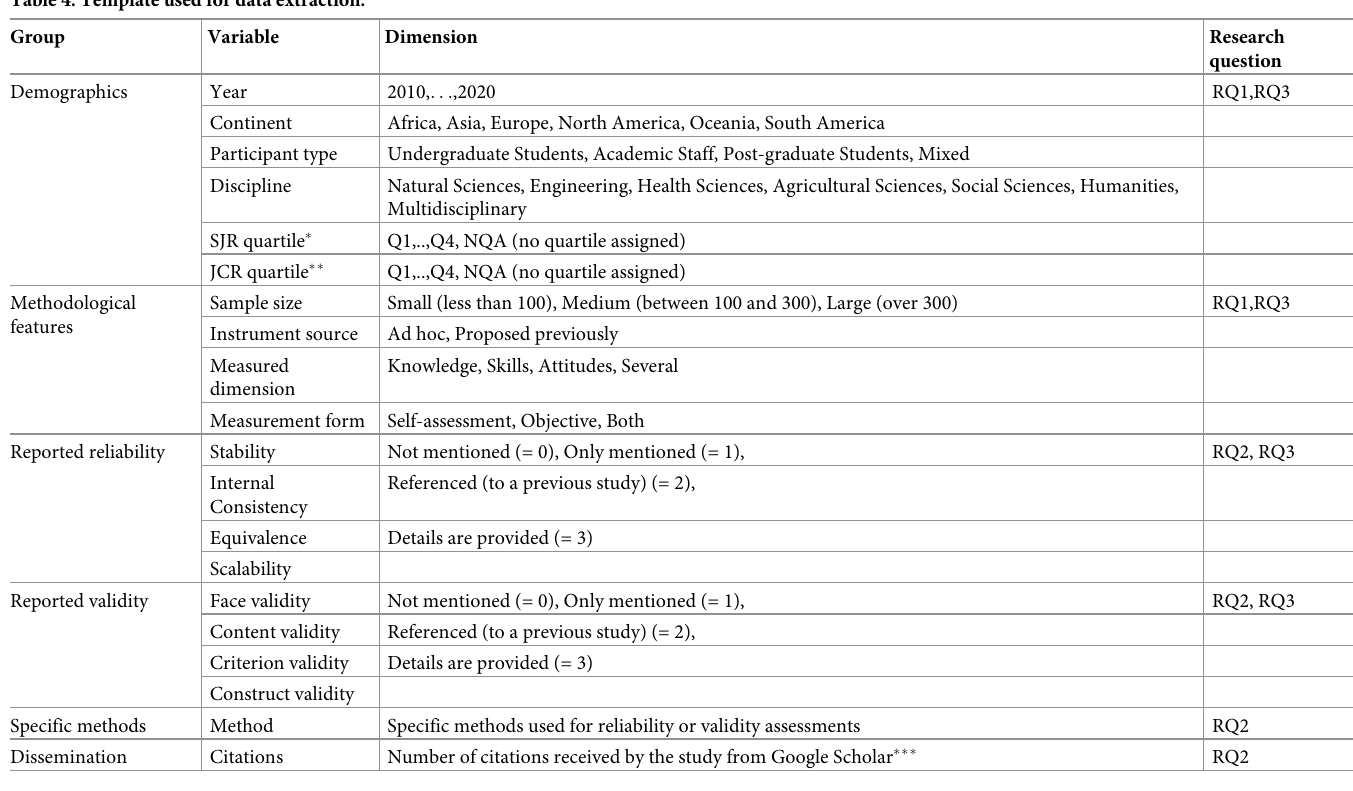
Table 4. Template used for data